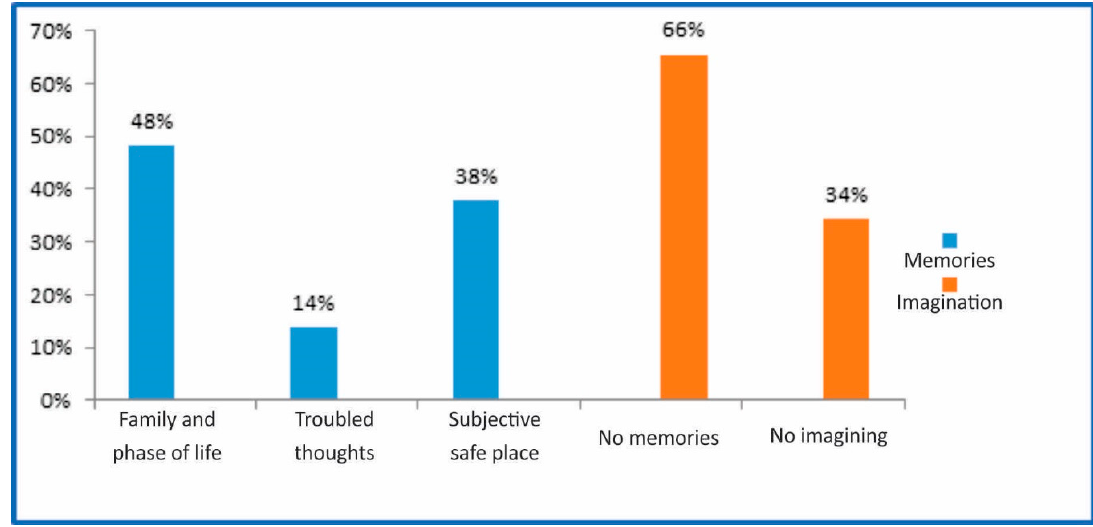
Figure 2. Correlation with memories and the walk.